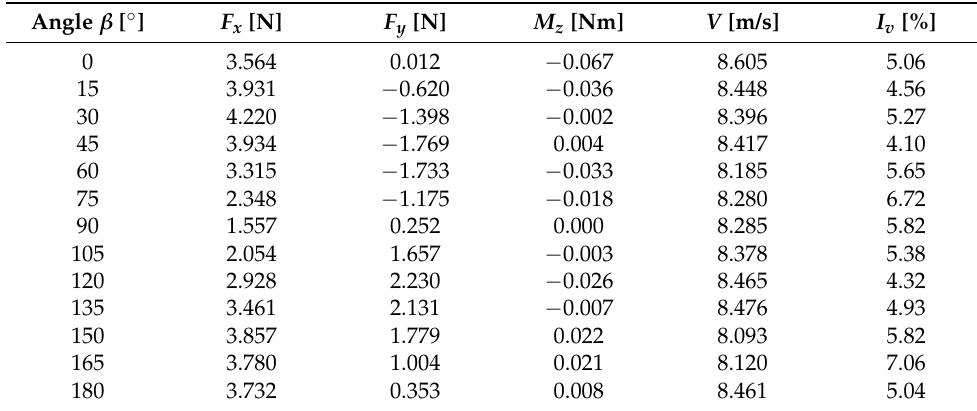
Table 3. Experimental results obtained for configuration 2.